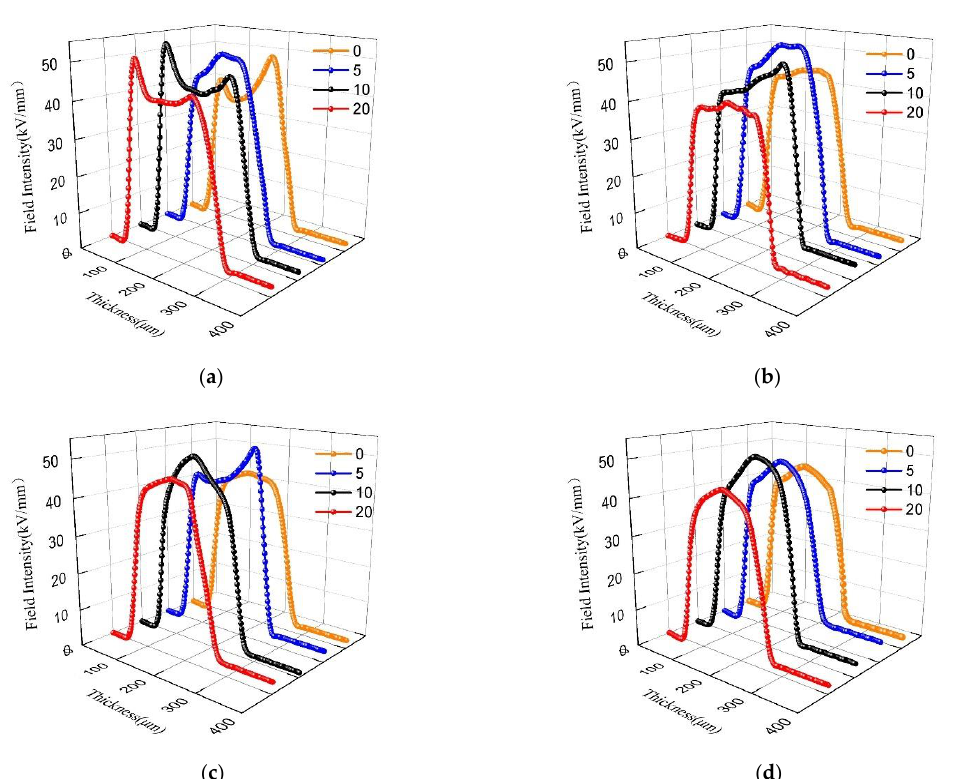
Figure 9. Electric field profiles in each sample with field intensity 40 kV/mm under different stretching ratio. ( a ) Sample 1; ( b ) Sample 2; ( c ) Sample 3; ( d ) Sample 4.